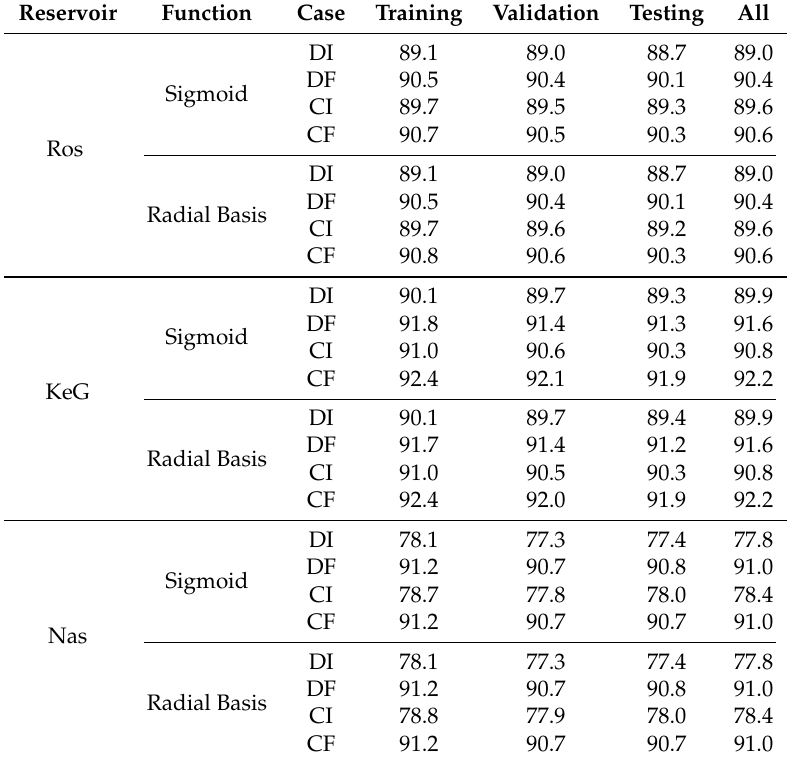
Table 3. Pearson’s correlation coefficient (rescaled to 100) for the identified control